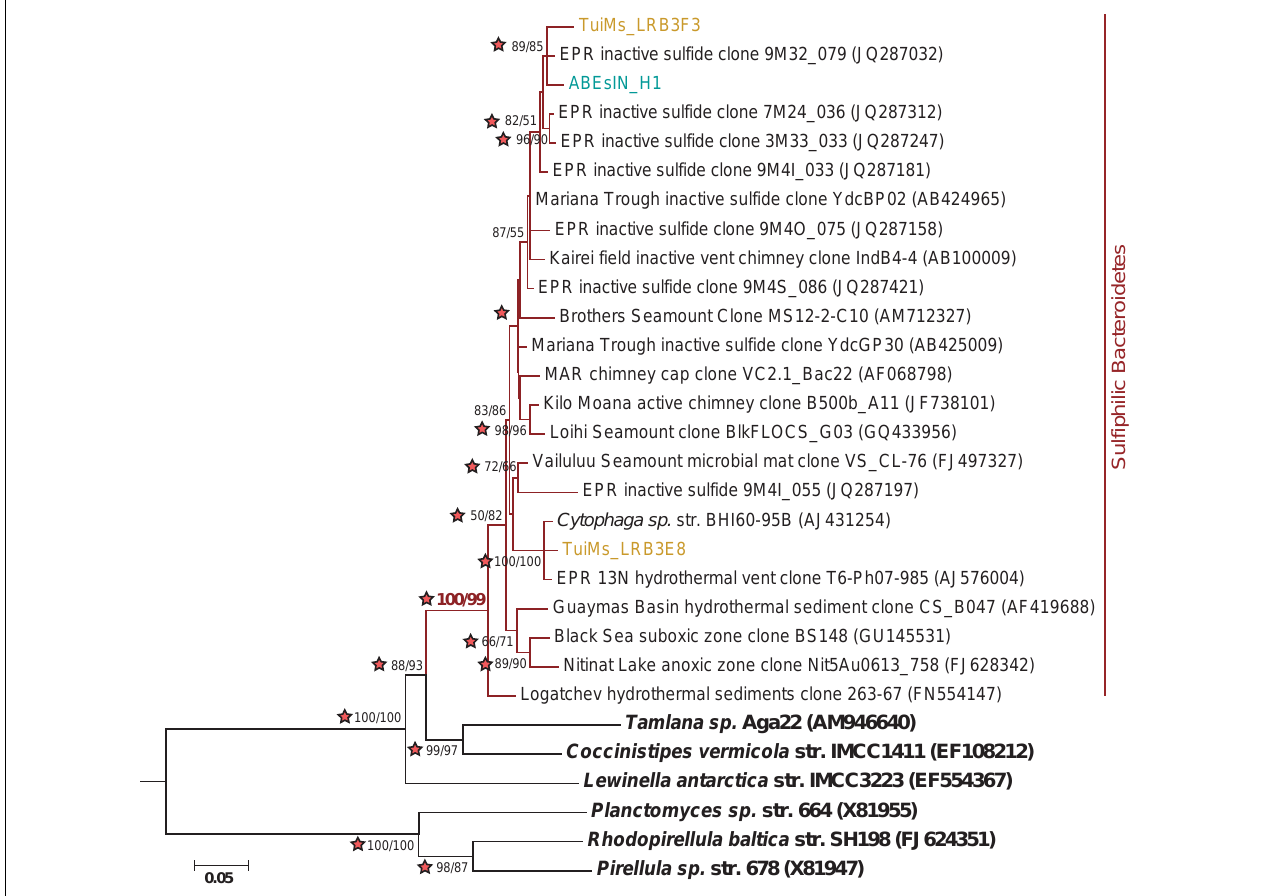
same alignment was used to generate a neighbor-joining tree with the maximum composite likelihood method and 1000 bootstrap replicates. Nodes where both methods agree and bootstrap support is > 50% are indicated with bootstrap values from the neighbor-joining tree on the left and the maximum likelihood tree on the right. Stars indicate nodes supported by Bayesian analysis. Nitrospira marina was used as an